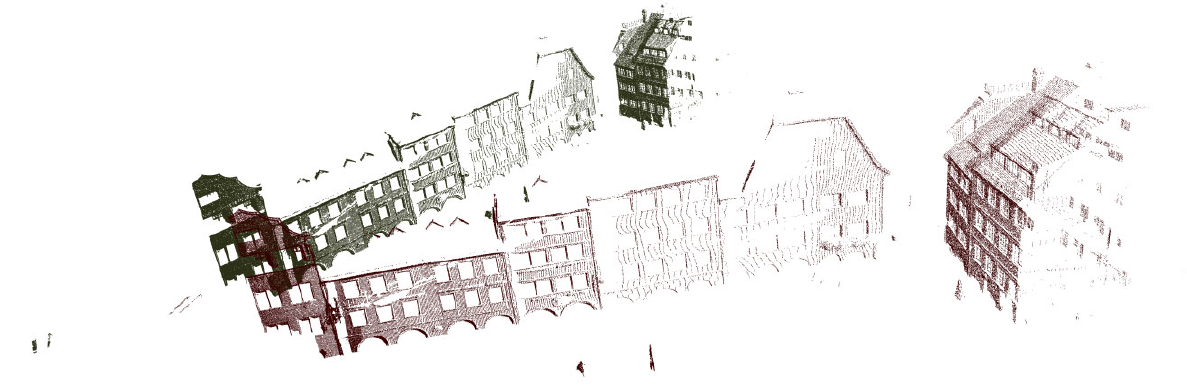
Figure 12. Partial outdoor point cloud registration initial position.